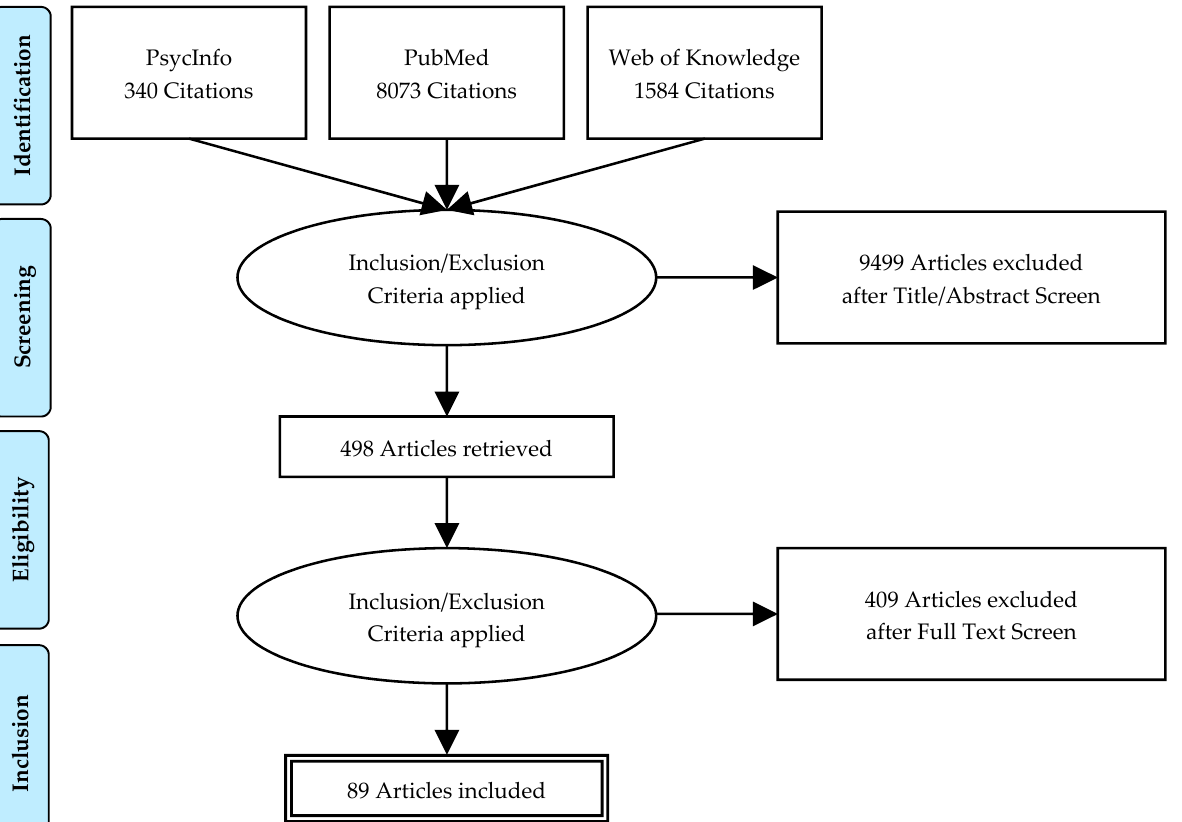
Figure 1. PRISMA flowchart of a systematic review of sleep andand fatigue in cancer.